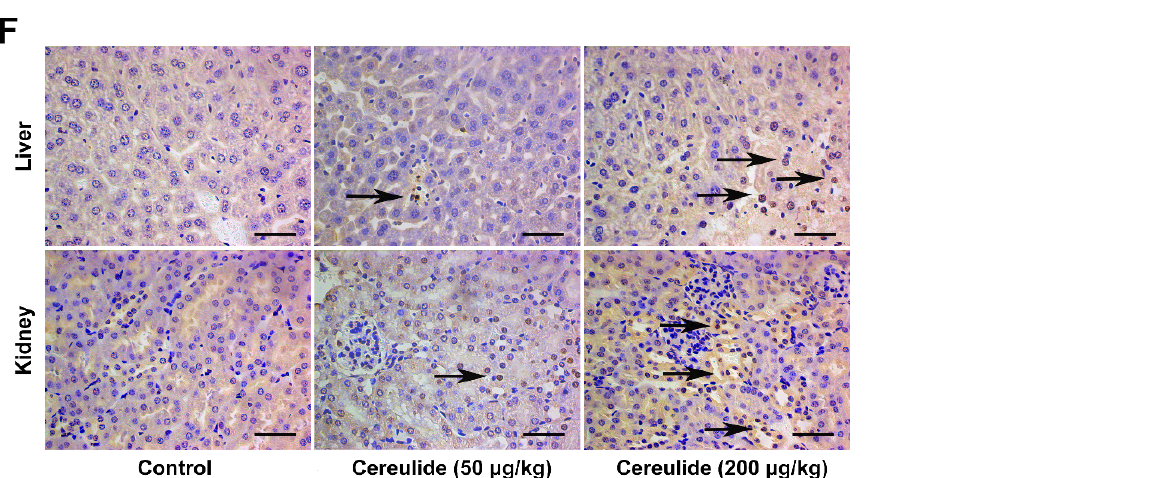
Figure 2. Long-time exposure to cereulide triggers ER stress and induces apoptosis of liver and kidney cells in mice. ( A , B ) The mRNA levels of XBP1 , XBP1s , IRE1 α , ATF4 and BiP were detected in liver and kidney tissues by RT-qPCR. Data are shown as the mean ± SD ( n = 5). ( C , D ) Western blot analysis for IRE1 α , p-IRE1 α , XBP1s, PERK, p-PERK, p-eIF2 α , and CHOP in the liver and kidney tissues of mice exposed to cereulide (50 and 200 µ g/kg). ( E , F ) TUNEL analysis of apoptosis level in liver and kidney tissue of mice exposed to cereulide (200 µ g/kg). Arrows indicated apoptotic cells. Image magnification: × 400; scale bar = 50 µ m. Data are presented as the mean ± SD ( n = 6). For all panels, * p < 0.05, ** p < 0.01 and *** p < 0.001 compared to the control group.